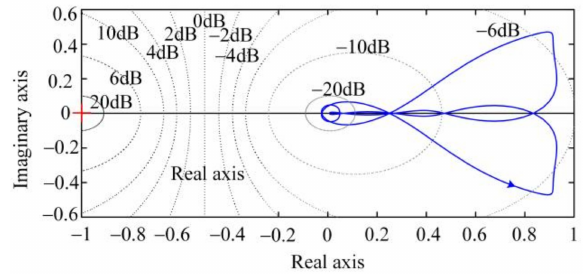
Figure 13. Nyquist curve of H ( z ).